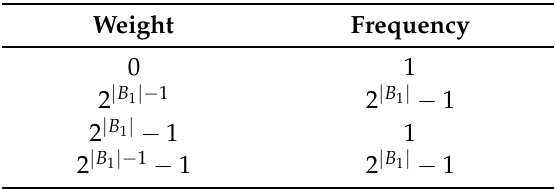
Table 2. Weight distribution of the code in Theorem 1